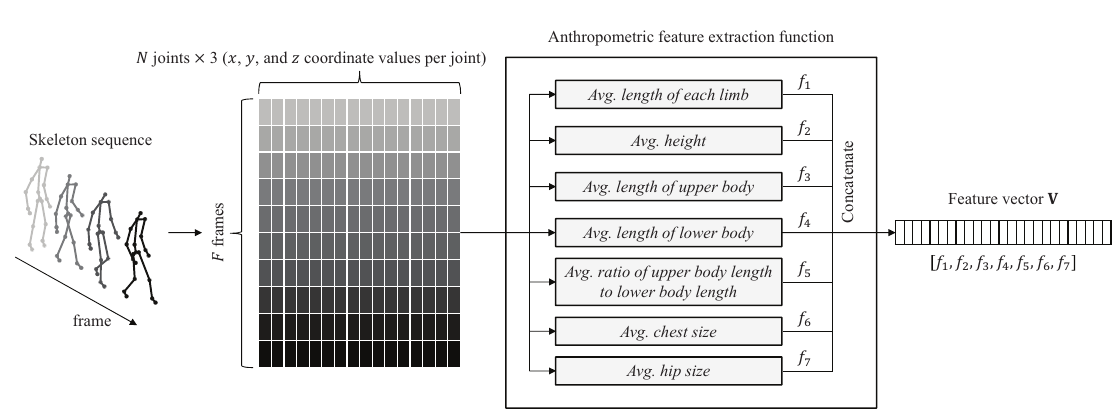
Figure 6. Overall procedure to generate feature vector V from skeleton sequence.